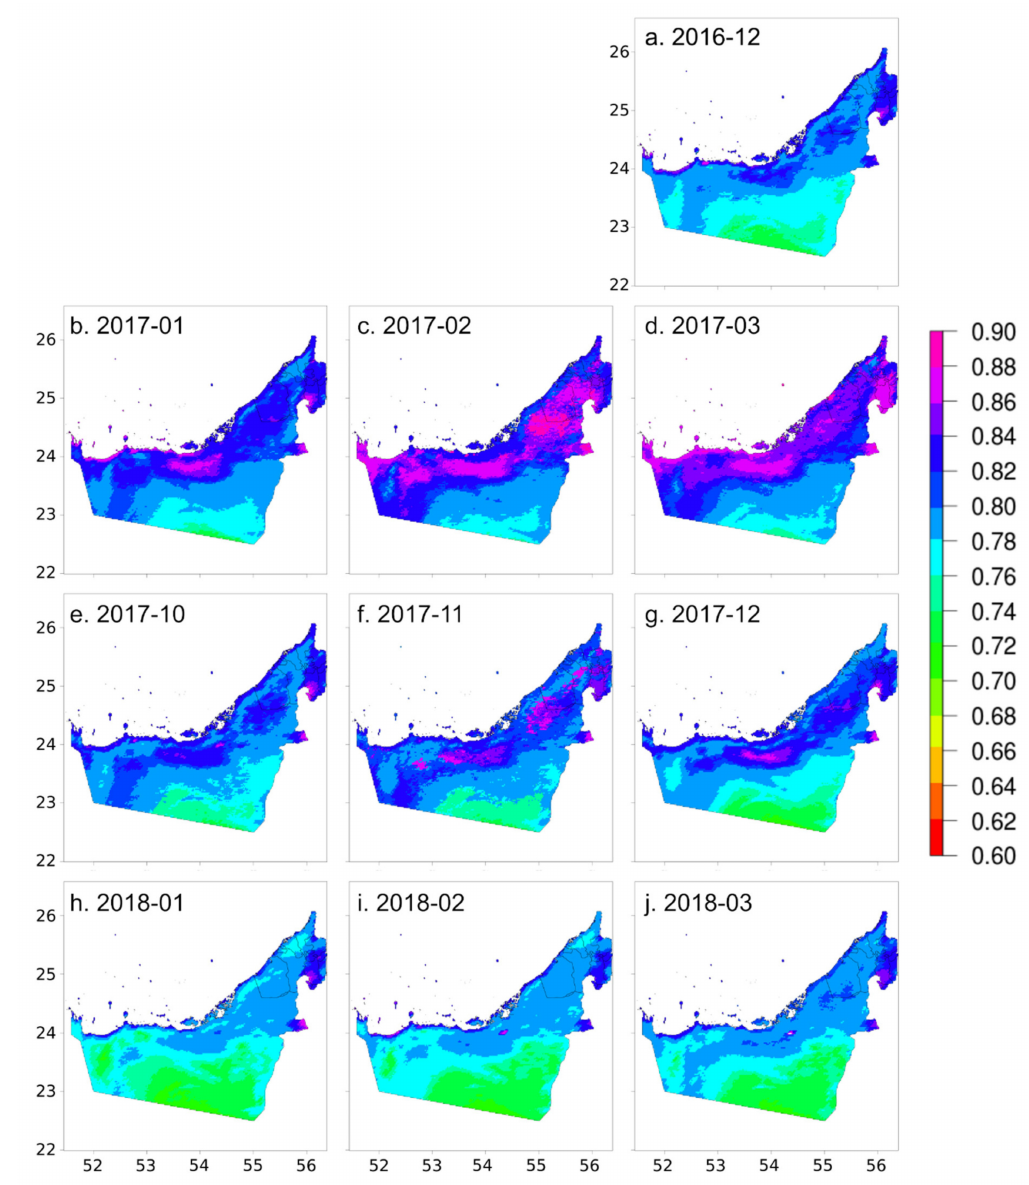
Figure 6. Spatial distribution of monthly threshold value of ems(3.9) from ( a – d ) December 2016 to March 2017 and ( e – j ) October 2017 to March